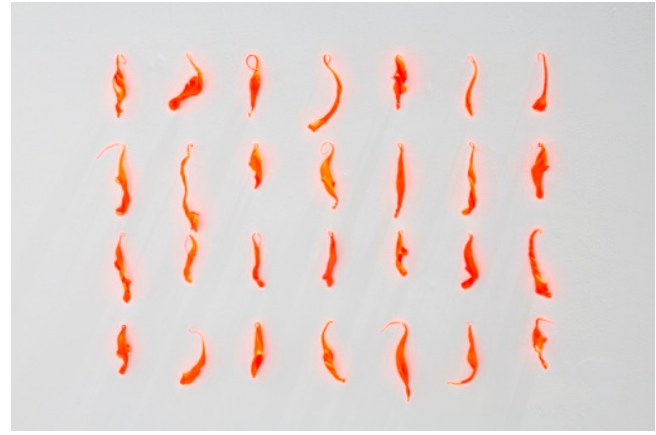
Figure 3. Vibrant Matter (2017) by Helen Pailing. Waste glass and acrylic paint. Variable size.